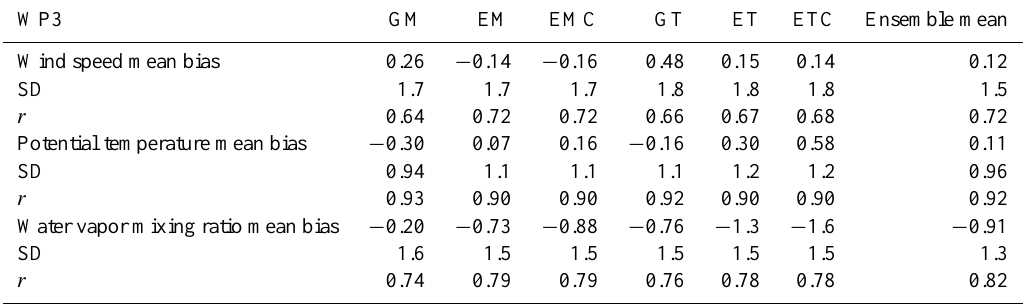
Table 2. Comparison statistics for all WP3 aircraft flights below 1000ma.s.l. Model points are extracted along the flight track every 10s, linearly interpolated in space and time, and then averaged to 120s. SD is the standard deviation of the differences, and r is the Spearman rank correlation coefficient. Units are ms − 1 for wind speed, K for potential temperature, and gkg − 1 for water vapor mixing ratio. Sign of bias is model–measurement. Number of points is